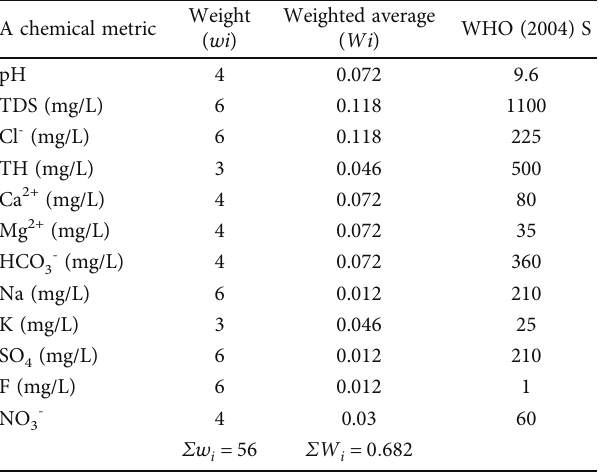
Table 4: Diverse water quality characteristics weight and relative